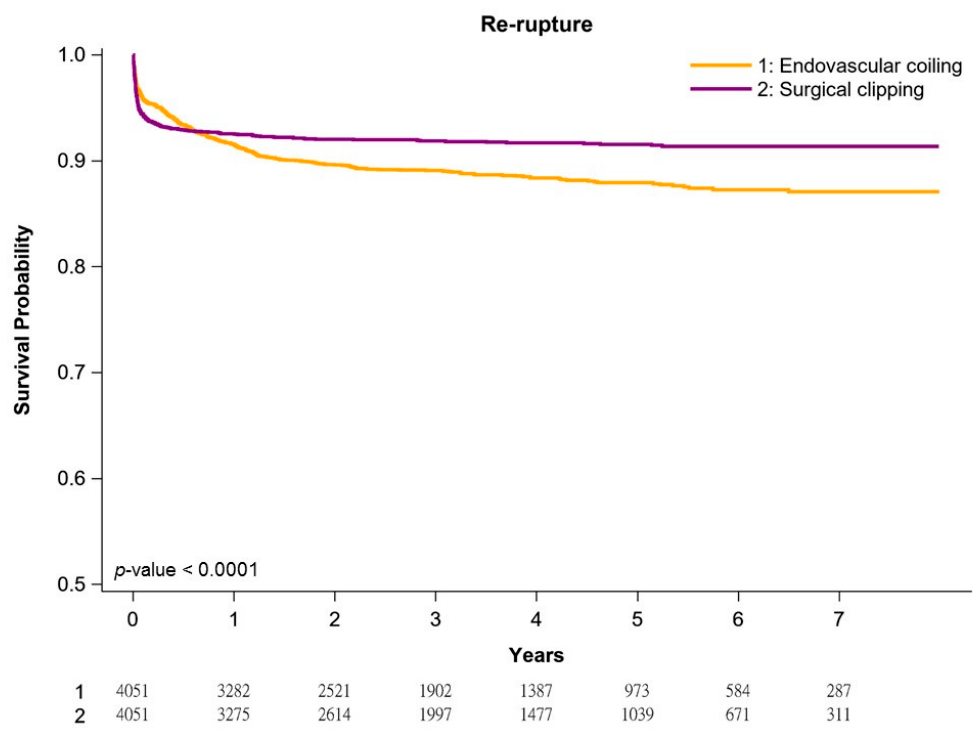
Figure 1. Kaplan–Meier re-rupture-free survival curves of propensity score-matched patients.